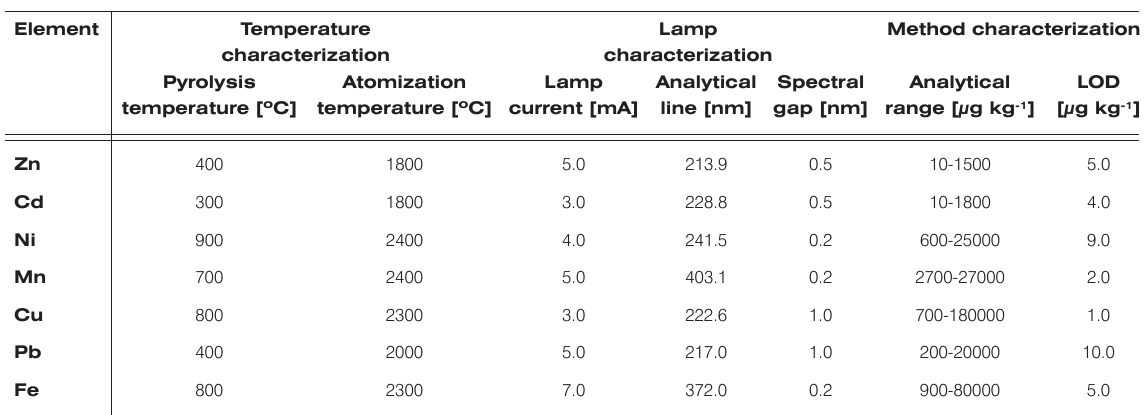
Table 1. Conditions of AAS analysis.